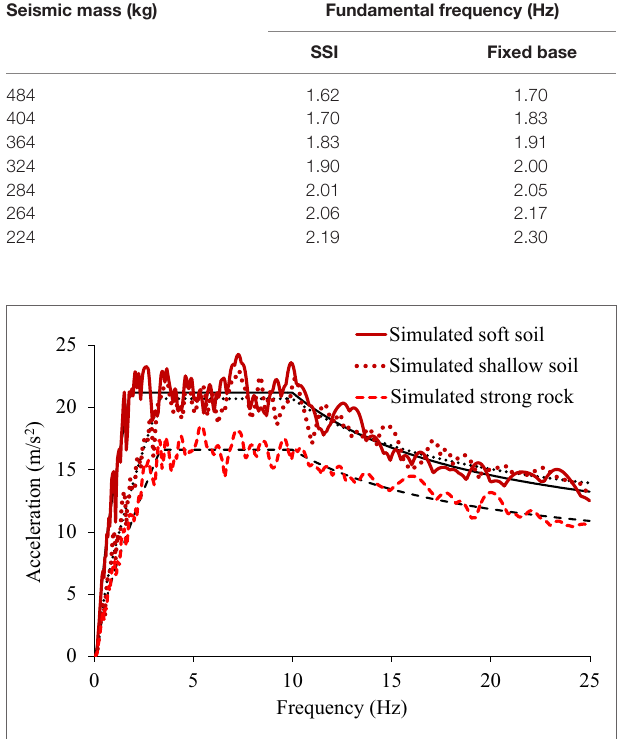
FigUre 6 | response spectra of the simulated excitations (bold curves) and the target design spectra (thin curves) for three different soil conditions .